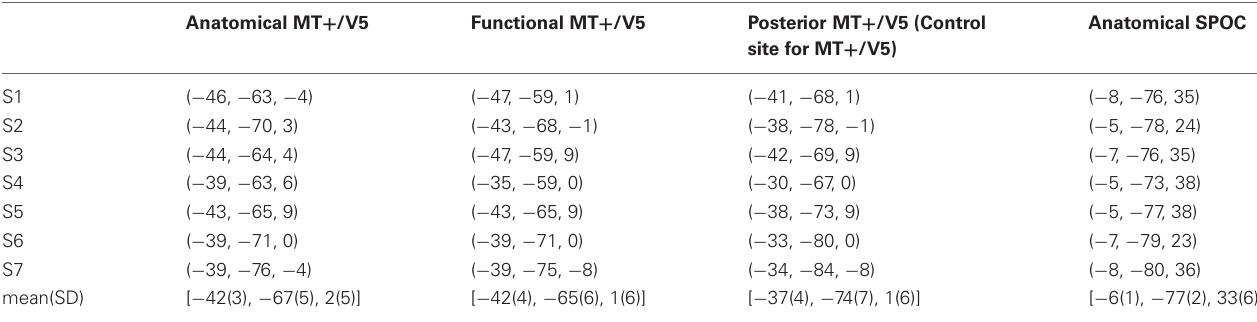
Table 1 | Talairach coordinates of the relevant target areas for all